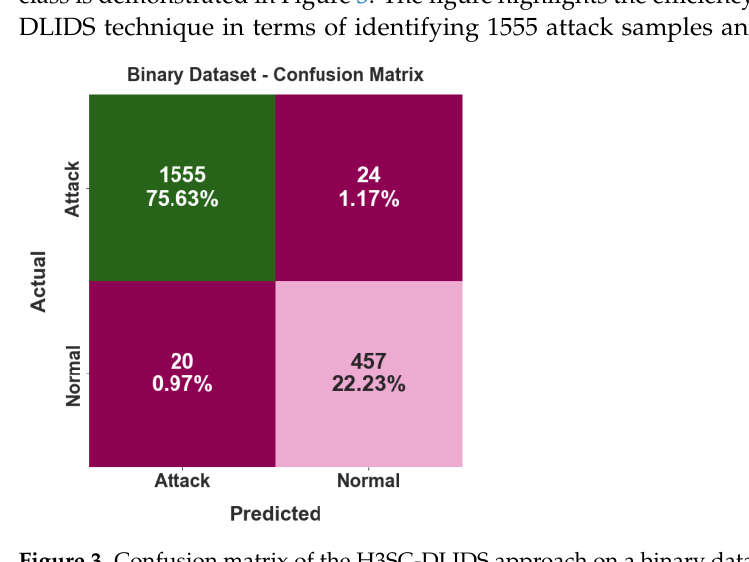
Figure 3. Confusion matrix of the H3SC-DLIDS approach on a binary dataset.